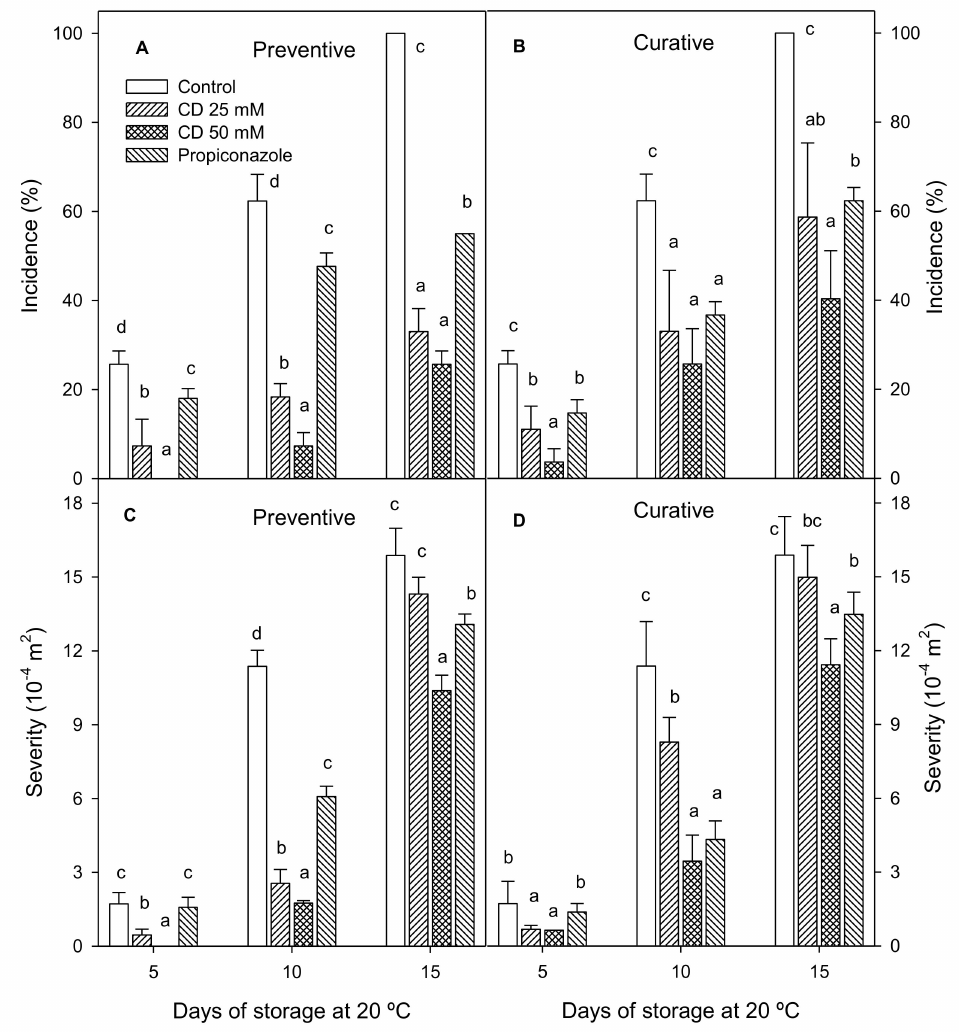
Figure 1. Incidence (%) of fruit a ff ected by G. citri-aurantii when 25 or 50 mM 2-hydroxylpropyl-beta- cyclodextrin (HP- β -CD)-thymol or propiconazole were applied as preventive ( A ) or curative ( B ) experiments. Severity (m 2 ) of decayed lemons by G. citri-aurantii when 25 or 50 mM HP- β -CD-thymol or propiconazole were applied as preventive ( C ) or curative ( D ) experiments. Data are the mean ± SE. Di ff erent letters show significant di ff erences ( p < 0.05) among treatments for each sampling